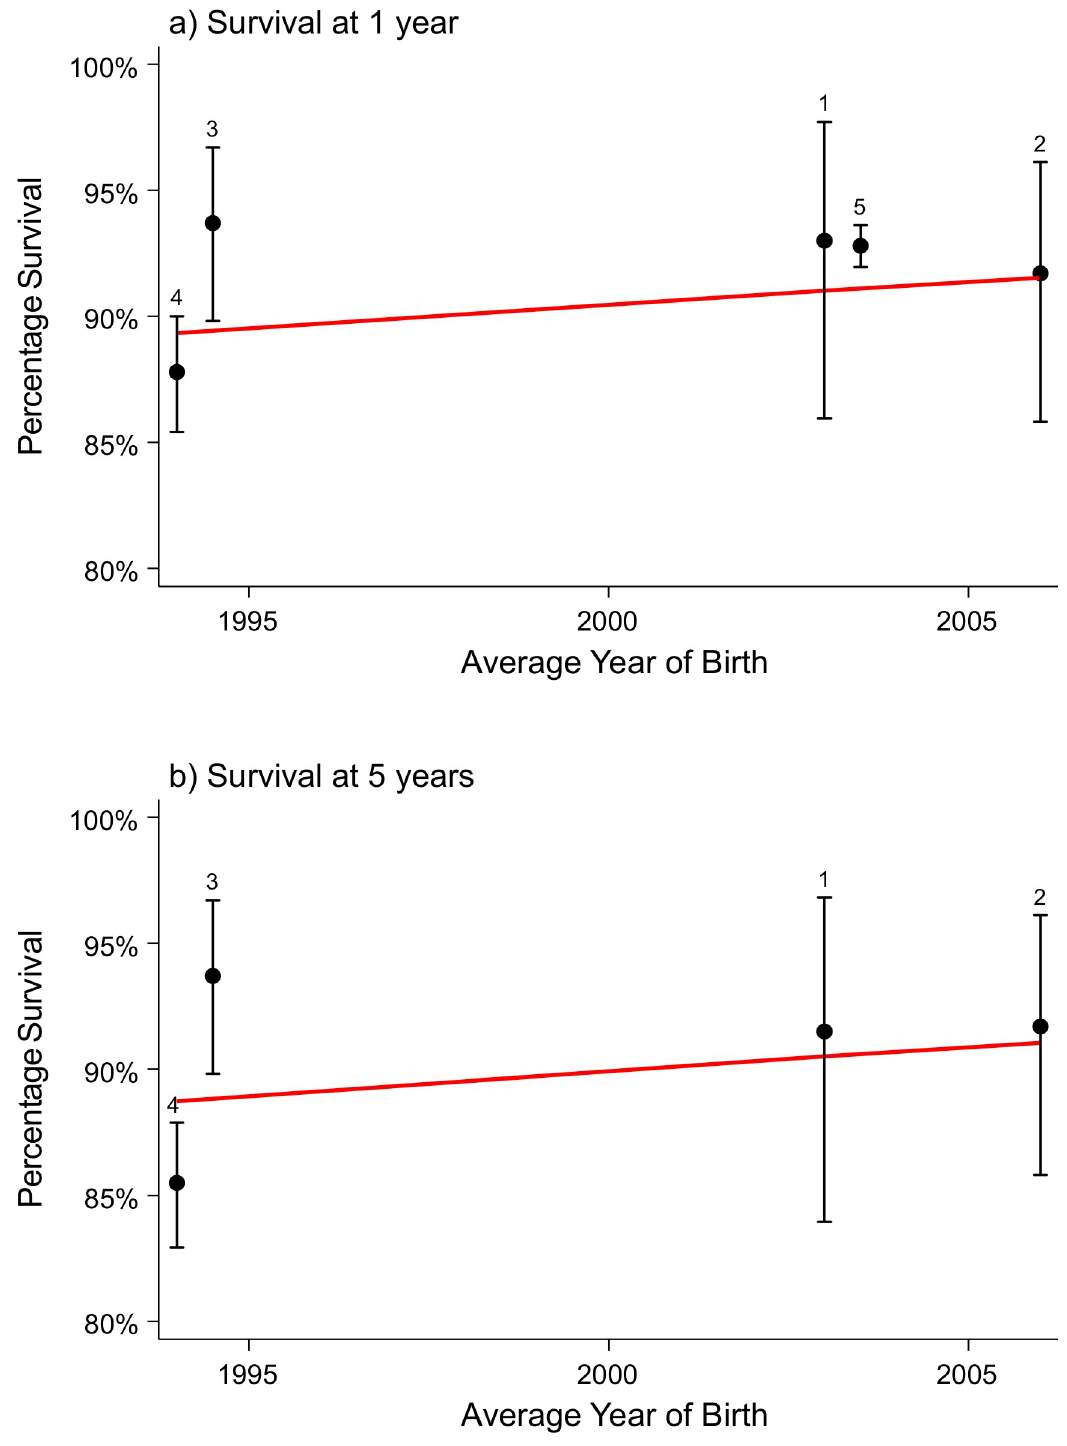
Fig 6. Survival estimates (with 95% confidence intervals) of children with gastroschisis at 1 (a) and 5 (b) years of age over time (5 studies). The numbers at survival points indicate the included study: 1—Risby, 2017, southern Denmark; 2—Schneuer, 2019, New South Wales, Australia; 3—Tennant, 2010, Northern England; 4—Wang, 2011, USA; 5—Wang, 2015, USA.